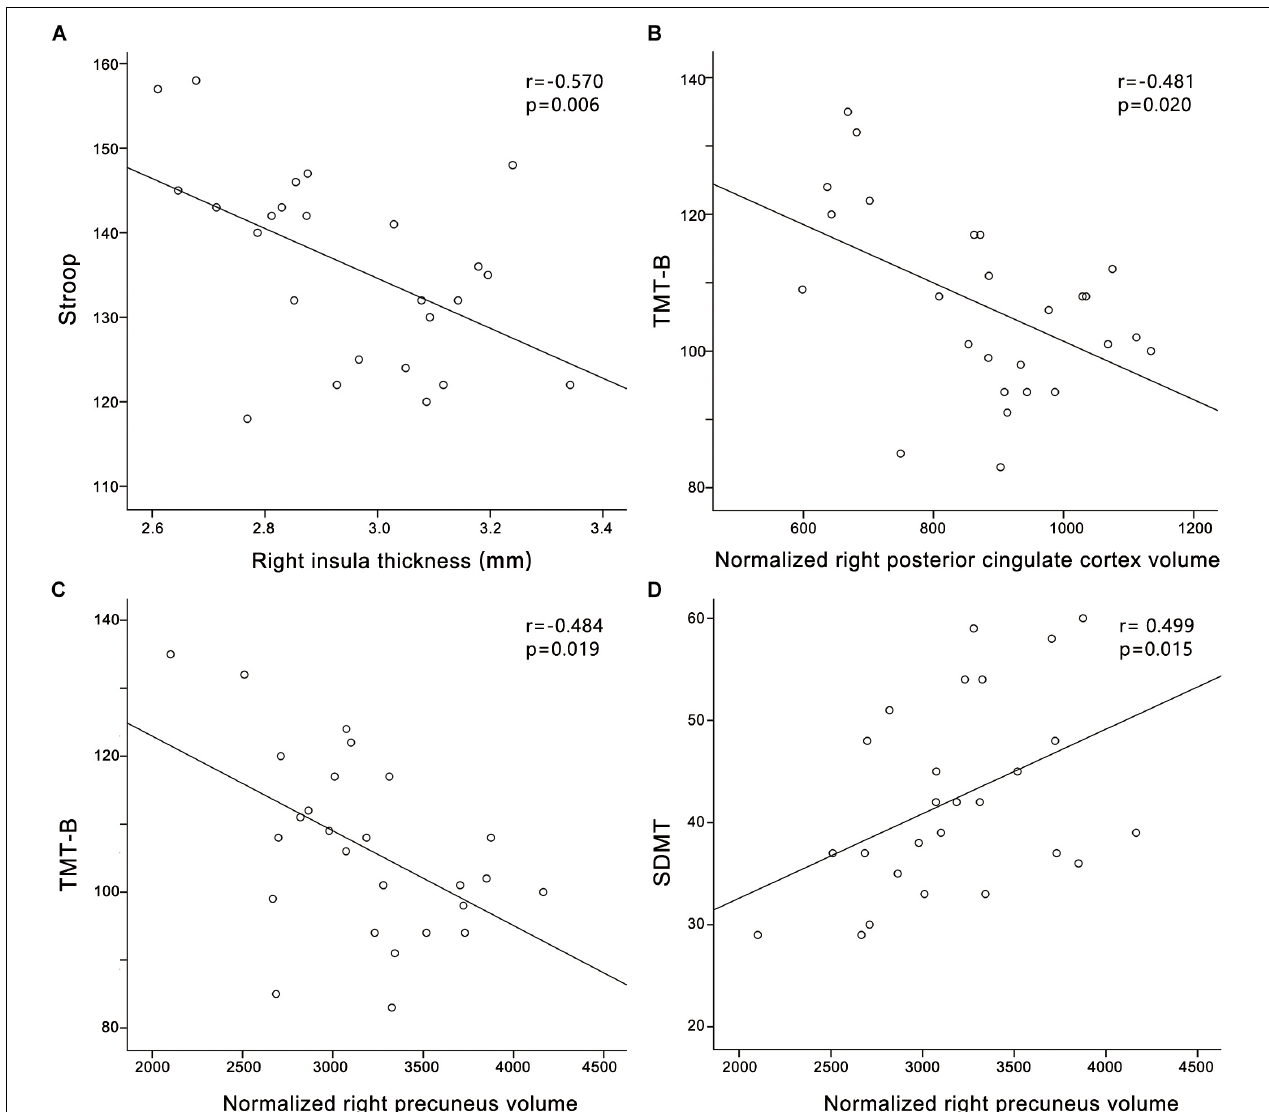
FIGURE 4 | Correlations between structural changes and cognitive impairments in the presbycusis group. (A) Stroop scores were negatively correlated with the cortical thickness of the right insula ( r = –0.570, p = 0.006); (B) TMT-B scores were negatively correlated with the cortical volume of the right posterior cingulate cortex ( r = –0.481, p = 0.020); (C) TMT-B scores were negatively correlated with the cortical volume of the right precuneus ( r = –0.484, p = 0.019); (D) SDMT scores were positively associated with the cortical volume of the right precuneus ( r = 0.499, p = 0.015). Normalized cortical volume = (cortical volume/intracranial volume)